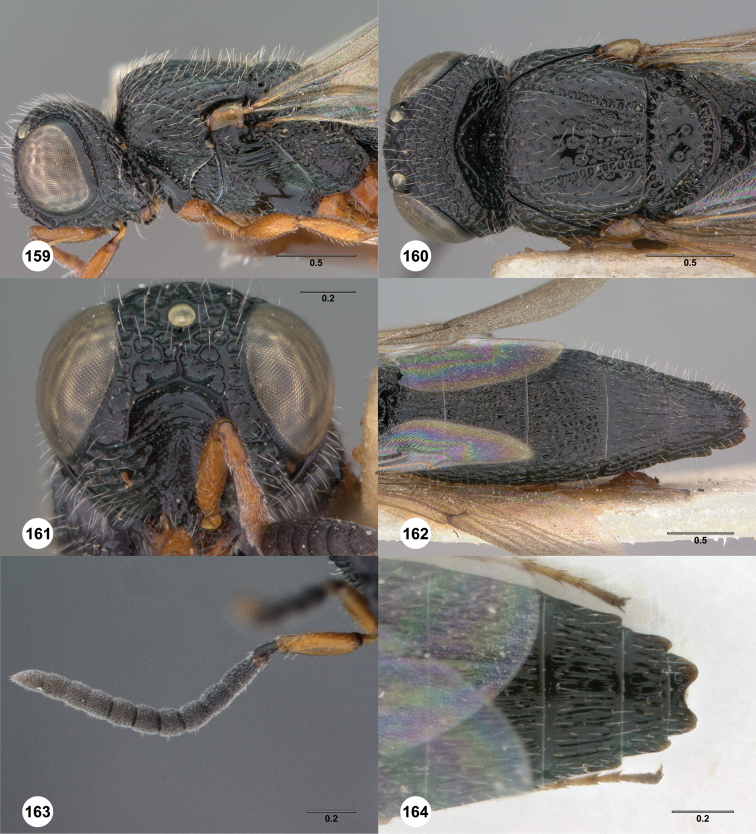
Oxyscelio limbi sp. n., paratype female (OSUC 436019) 159 Head and mesosoma, lateral view 160 Head and mesosoma, dorsal view 161 Head, anterior view 162 Metasoma, dorsal view. Paratype male (OSUC 376694) 163 Antenna 164 Metasoma, dorsal view. Morphbank58